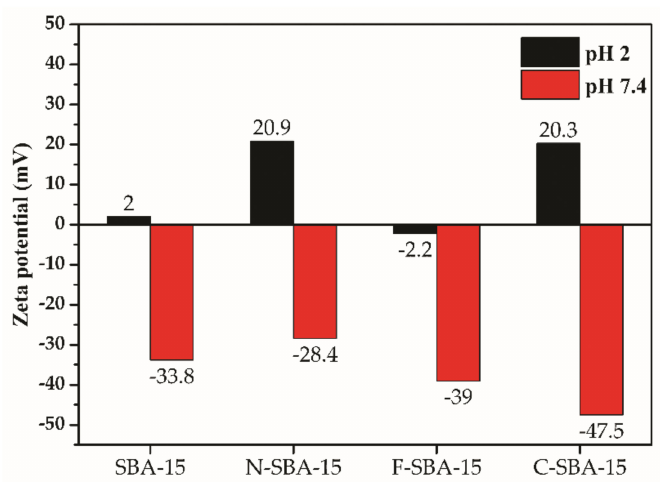
Figure 7. Zeta potential of SBA-15, N-SBA-15, F-SBA-15 and C-SBA-15 at pH 2 and pH 7.4.